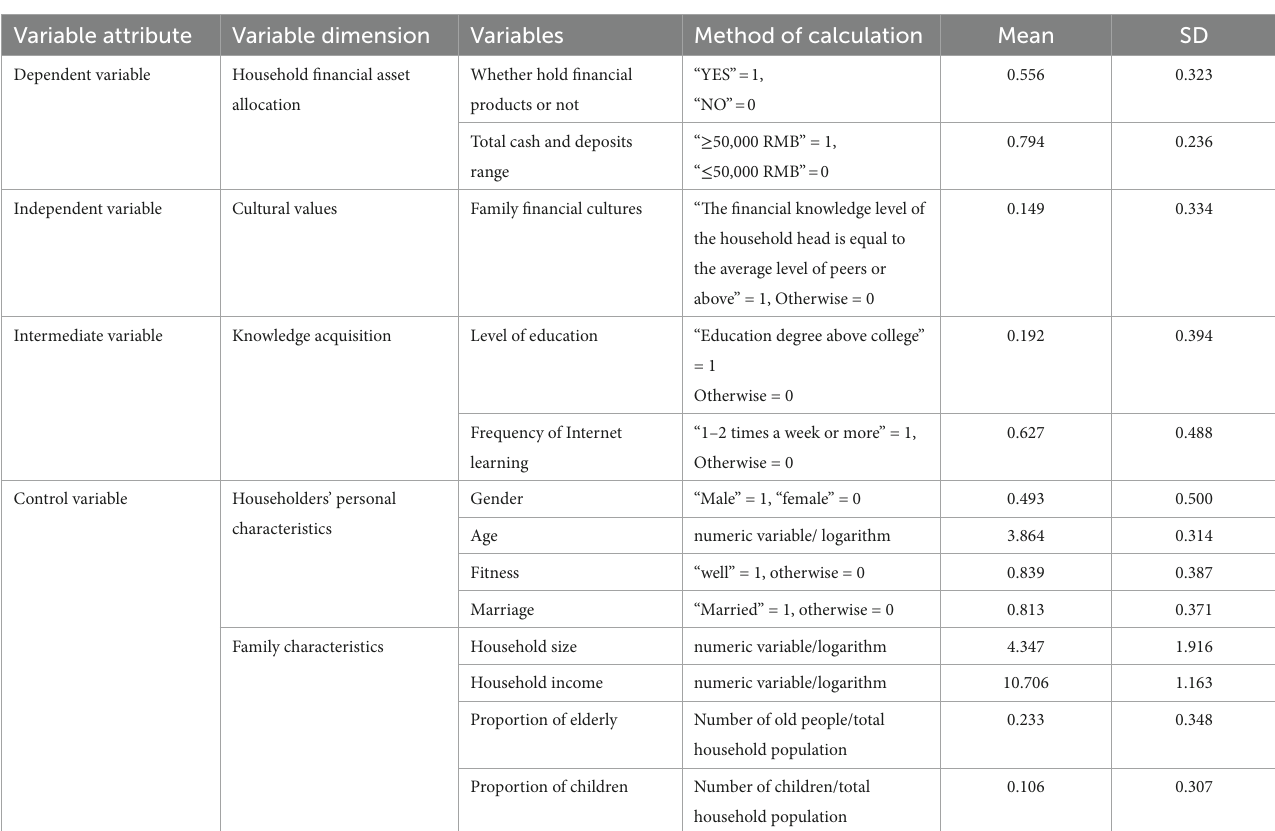
TABLE 1 Descriptive statistics ( N = 6,623).